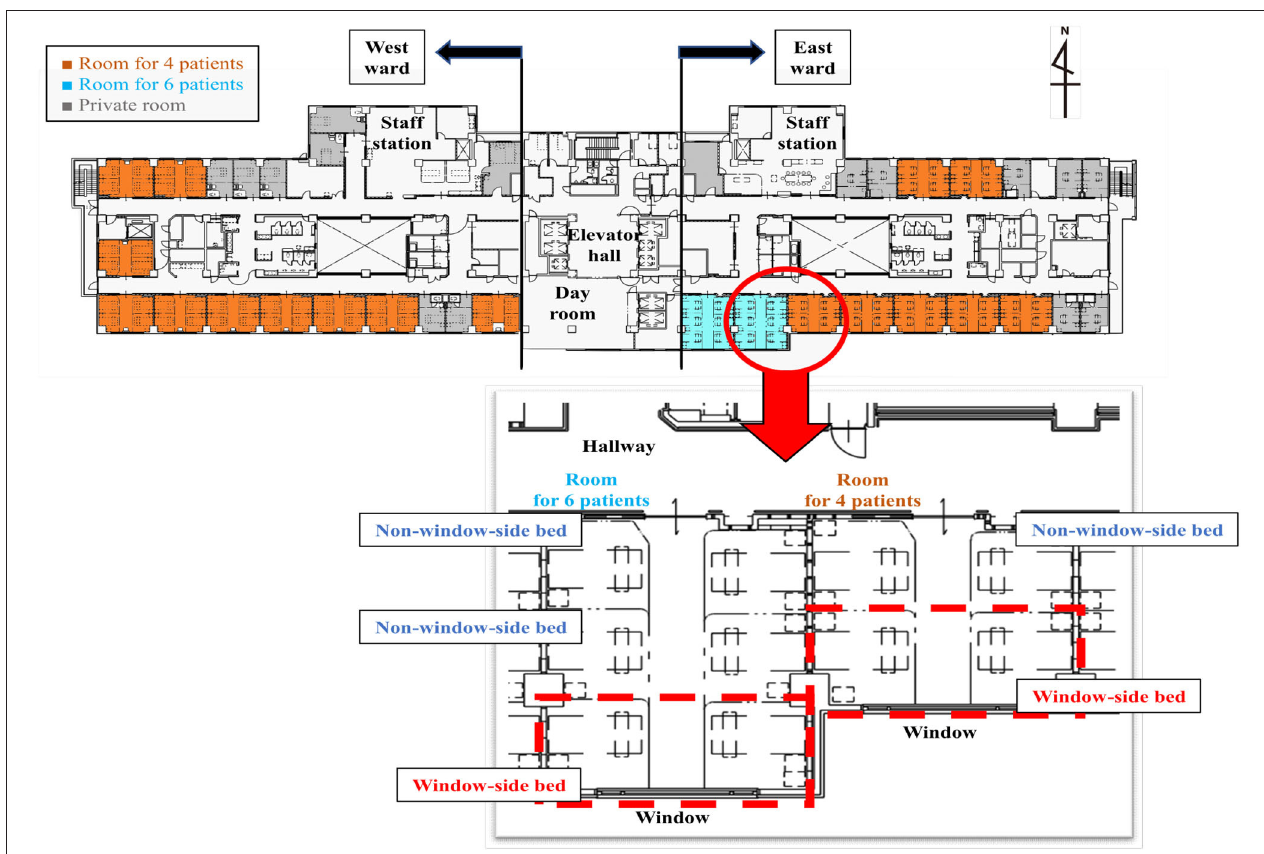
FIGURE 1 | Map of a general hospital ward. The map shows the layout of a general ward at Shinshu University Hospital. There are two types of multi-patient rooms: rooms for four patients and rooms for six patients. In both room types, the two beds nearest to the window are designated window-side beds (red dotted lines), while the others are designated non-window-side beds. Each bed is separated by a dividing